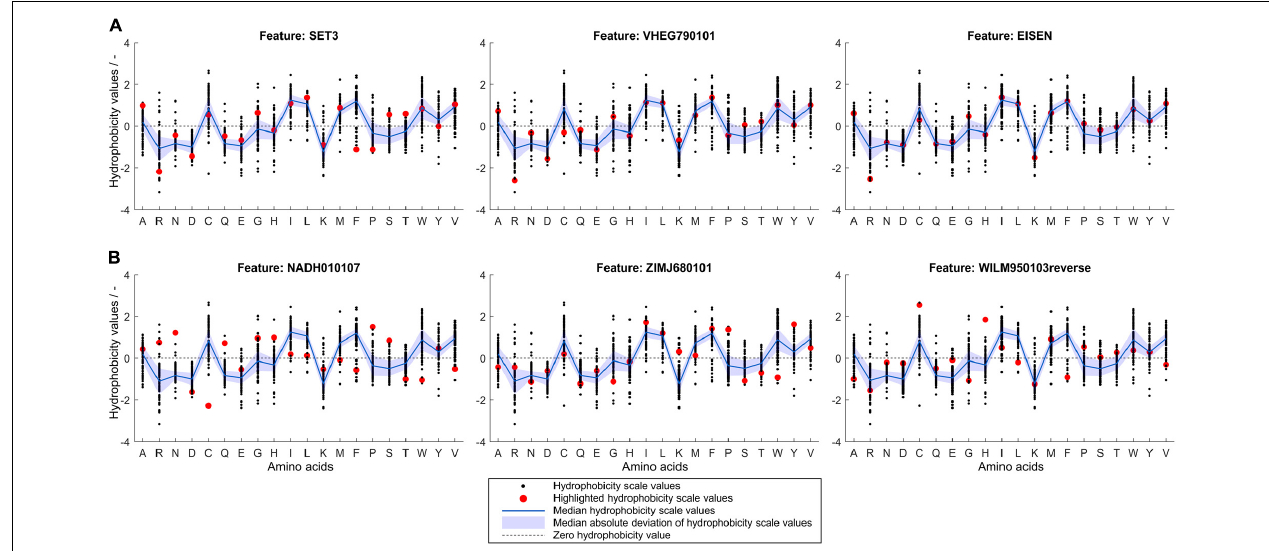
FIGURE 7 | Normalized hydrophobicity scale values for the 20 proteinogenic amino acids. Amino acids are shown on the x-axis indicated by single-letter code. In each graph, 91 scales’ amino acid hydrophobicity values are represented by black dots, their median is shown as a blue line with a shaded blue area representing the median absolute deviation. A dashed, horizontal line through zero is shown to guide the eye. The scale indicated by a subfigure title is highlighted in red for (A) the three scales with highest median feature importance and (B) the three scales with lowest median feature importance as determined in the learning experiment. The normalized scales’ sign was changed so that hydrophobicity of aspartic acid is always negative.